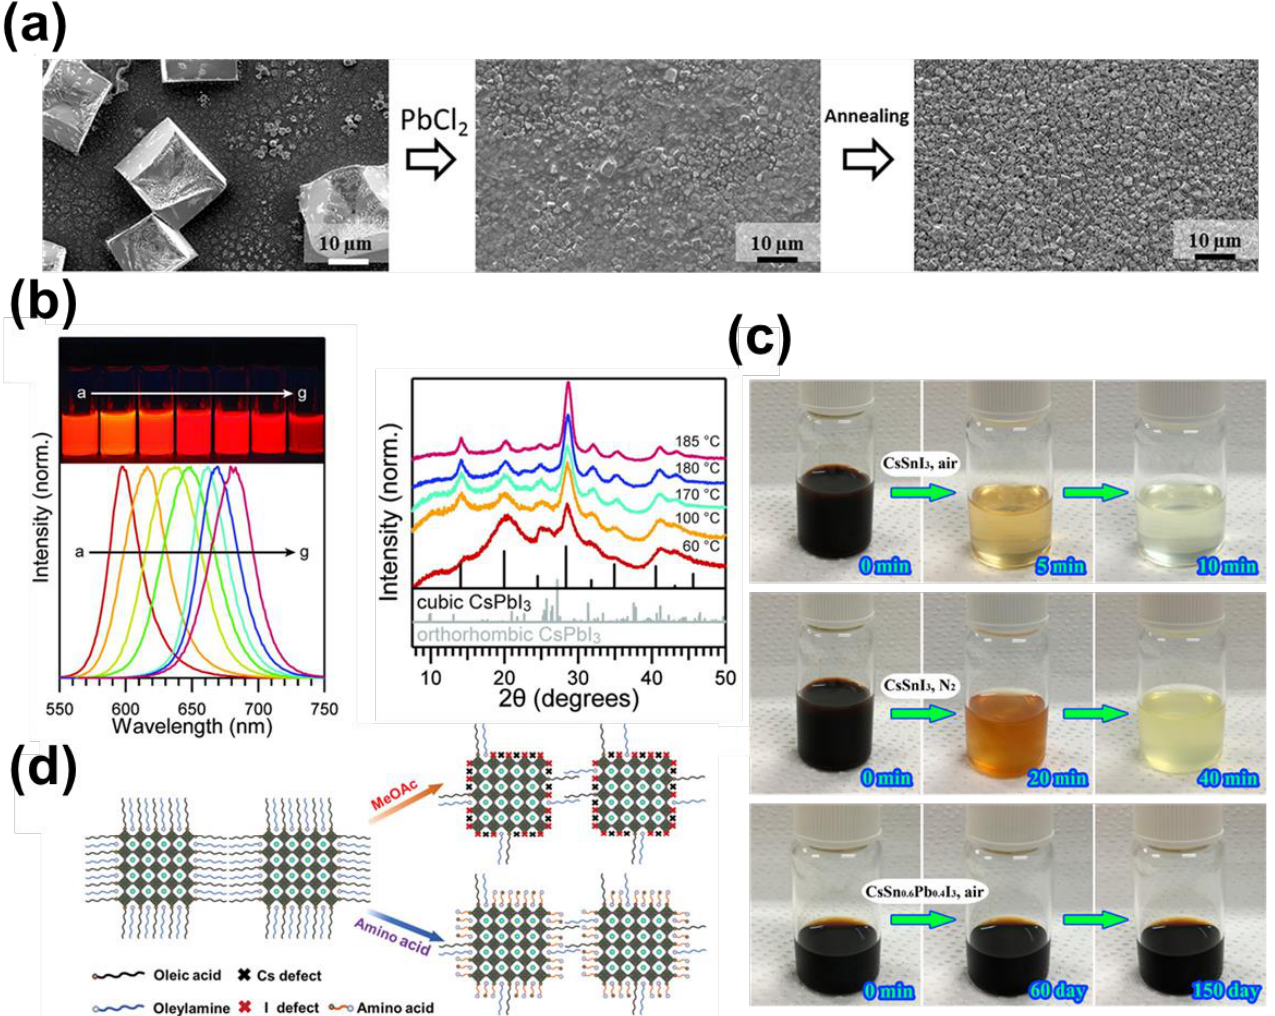
Figure 8. ( a ) SEM images of perovskite films deposited on dense TiO 2 from DMF at 80 °C substrate temperature [64]. Copyright 2014 American Chemical Society. ( b ) Normalized photoluminescence spectra and photographs under UV illumination of the CsPbI 3 NCs at different temperatures and XRD patterns of NCs synthesized at (from bottom to top) 60, 100, 170, 180, and 185 °C, confirming that they crystallize in the cubic phase of CsPbI 3 [65]. Copyright 2016 American Association for the Advancement of Science. ( c ) The photographs were taken at different periods for solutions of the as-synthesized CsSnI 3 NCs and the purified CsSn 0.6 Pb 0.4 I 3 NCs [66]. Copyright 2017 American Chemical Society. ( d ) Schematic illustration of the changes on the perovskite NC surface with conventional MeOAc rinse and dual-passivation ligands before and after ligand exchange [67]. Copyright 2020 John Wiley & Sons, Inc. Introducing additivities in perovskite NCs is another standard method to improve optoelectronic properties, such as A-site cation halide salt (AX) treatments, which can improve carrier transport. The study by Sanehira et al. tested a variety of AX salts. The best one doubled the mobility and led to an efficiency of 13.43%, which was the record for quantum dot solar cells at that time [68]. Recently, the same group used AX salts, FAI, to fabricate high-quality FA 1-x Cs x PbI 3 NCs and investigated the relationship between the treatment time and quality of the perovskite NC film. The best device achieved an efficiency of 13.4%